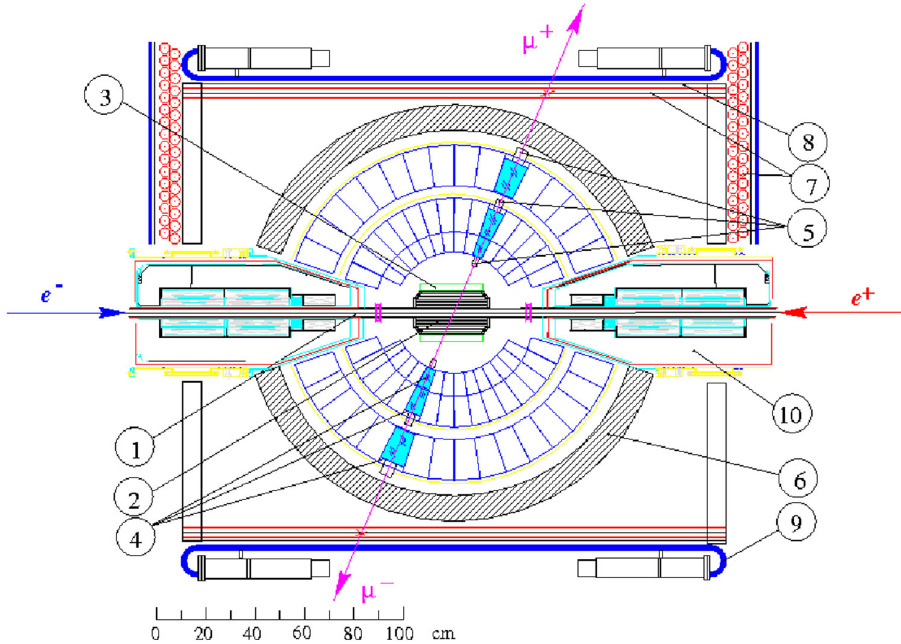
Fig. 1 SND detector, section along the beams: (1) beam pipe, (2) tracking system, (3) aerogel Cherenkov counters, (4) NaI (Tl) crystals, (5) vacuum phototriodes, (6) iron absorber, (7) proportional tubes,(8) iron absorber, (9) scintillation counters, (10) VEPP-2000 focusing